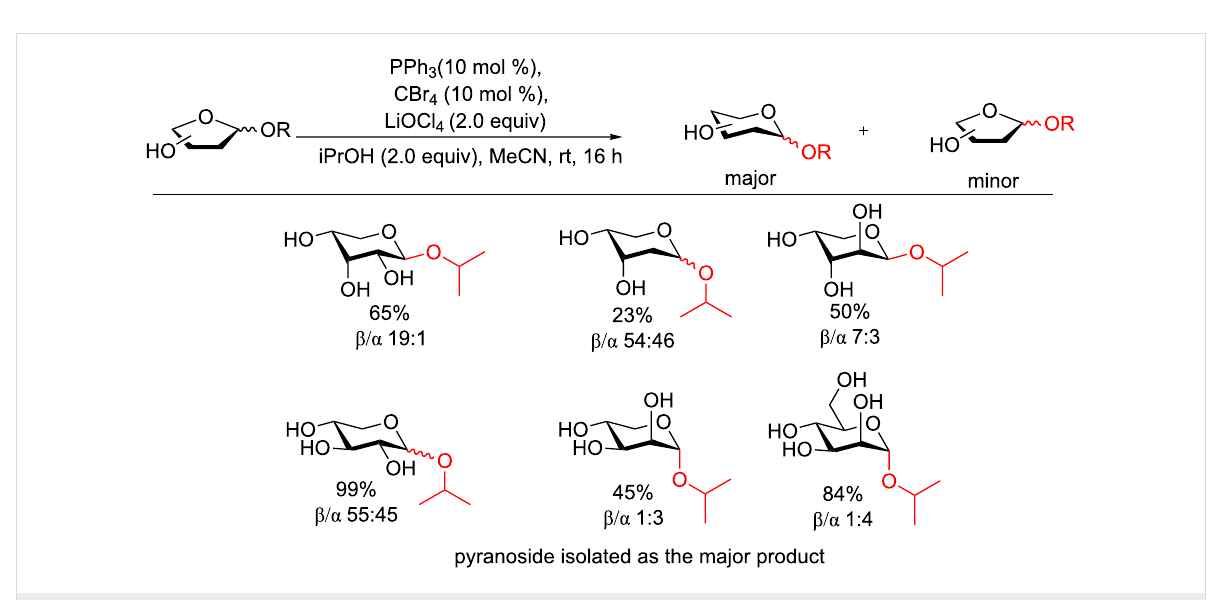
Figure 14: Access to glycosides using catalytic PPh 3 and CBr 4